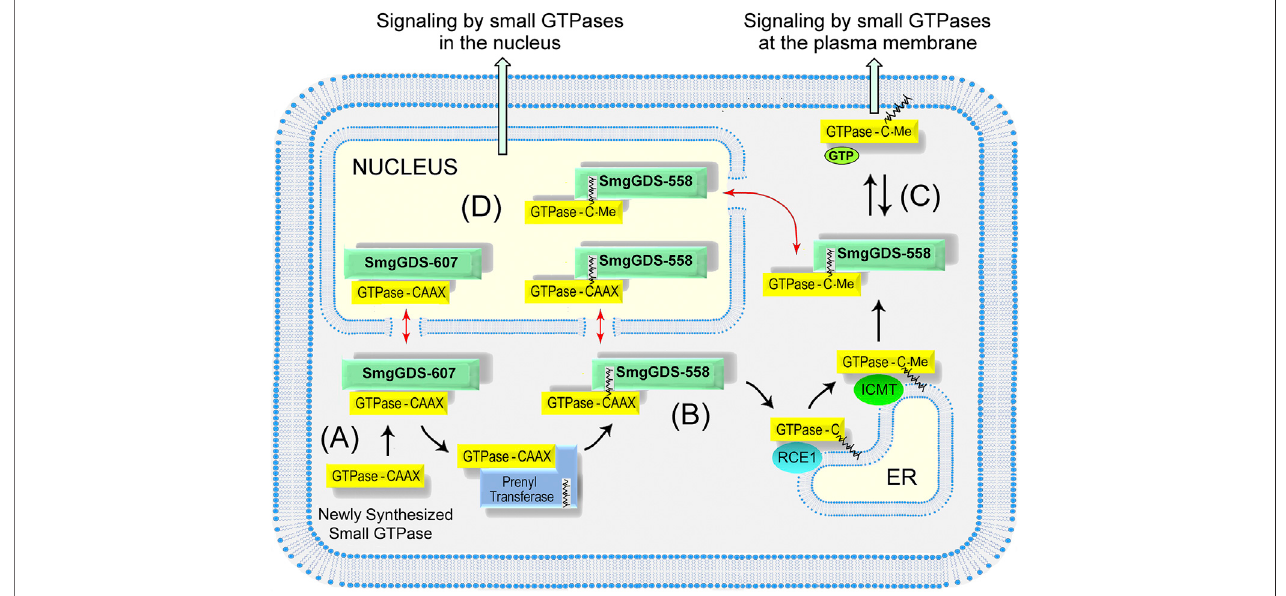
FIGURE 2 | Model depicting how SmgGDS splice variants regulate the prenylation and traf fi cking of small GTPases. (A) SmgGDS-607 binds a newly synthesized smallGTPaseandretainsituntilthecorrectsignalcausesSmgGDS-607toreleasethepre-prenylatedGTPasetothePTase. (B) SmgGDS-558escortsnewlyprenylated small GTPases to the ER for post-prenylation processing. (C) SmgGDS-558 escorts prenylated and fully processed small GTPases from the ER to the plasma membrane. (D) Both SmgGDS splice variants might assist in nucleocytoplasmic shuttling of small GTPases (red